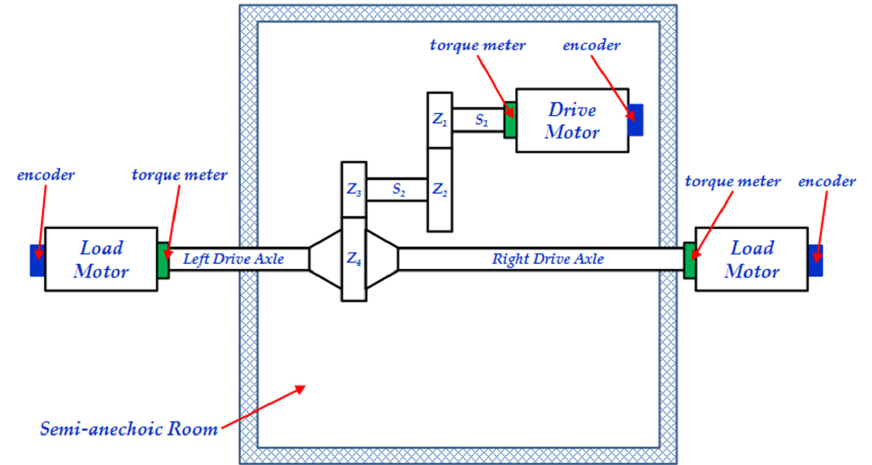
Figure 6. Test rig layout and measurement method.